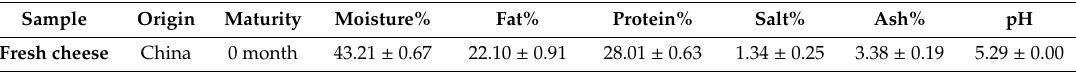
Table 3. Basic information and chemical composition of the cheddar cheese